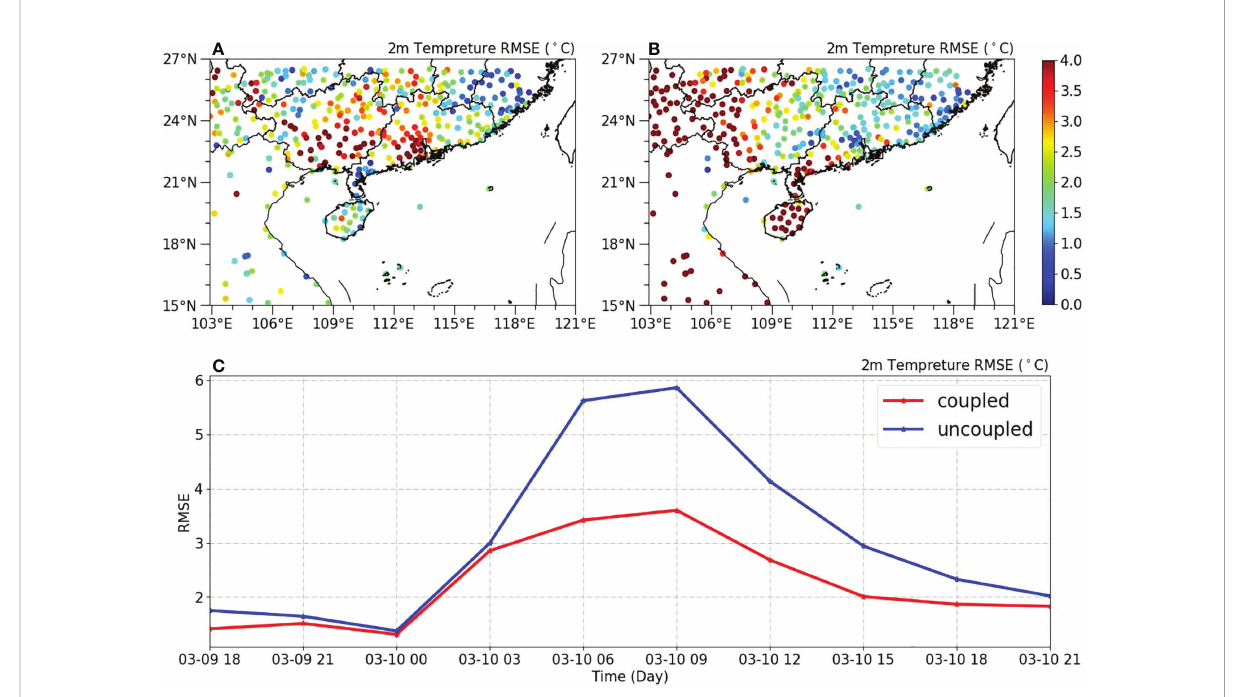
FIGURE 4 Spatial distribution of 2 m air temperature RMSE for (A) the coupled model and (B) the uncoupled model) and (C) time